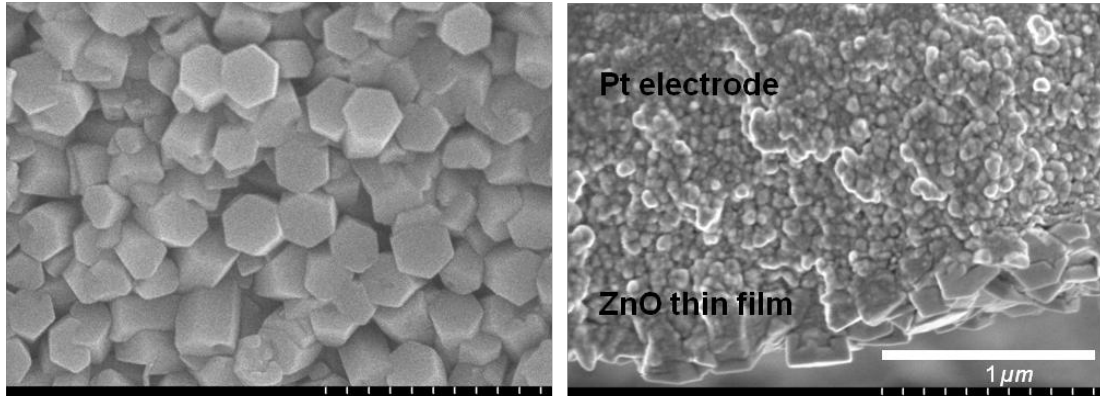
Figure 4. SEM of IPMZC showing hexagonal ZnO crystal on IPMC